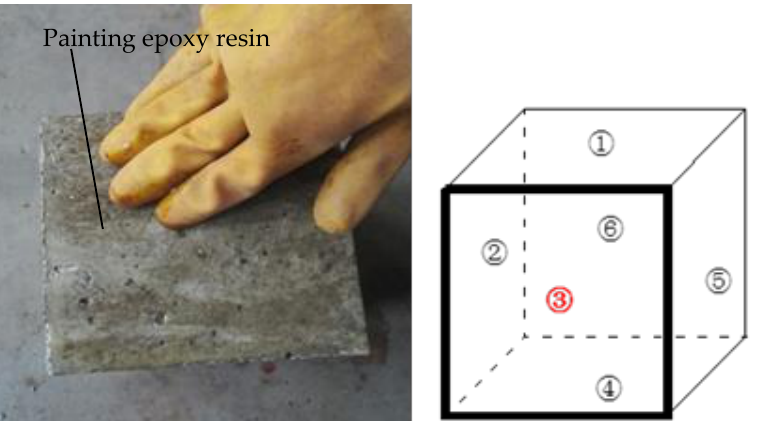
Figure 1. Process of painting epoxy resin.